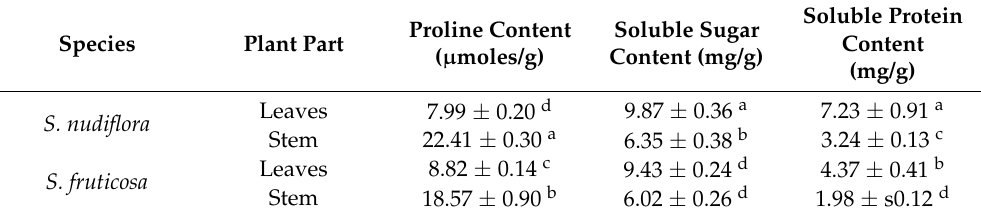
Table 3. Deposition of osmo-protective chemicals in leaves and stem parts of halophytes. Soluble Protein Proline Content Soluble Sugar Content Species Plant Part ( µ moles/g) Content (mg/g) (mg/g) Leaves 7.99 ± 0.20 d 9.87 ± 0.36 a 7.23 ± 0.91 a S. nudiflora Stem 22.41 ± 0.30 a 6.35 ± 0.38 b 3.24 ± 0.13 c Leaves 8.82 ± 0.14 c 9.43 ± 0.24 d 4.37 ± 0.41 b S. fruticosa Stem 18.57 ± 0.90 b 6.02 ± 0.26 d 1.98 ± s0.12